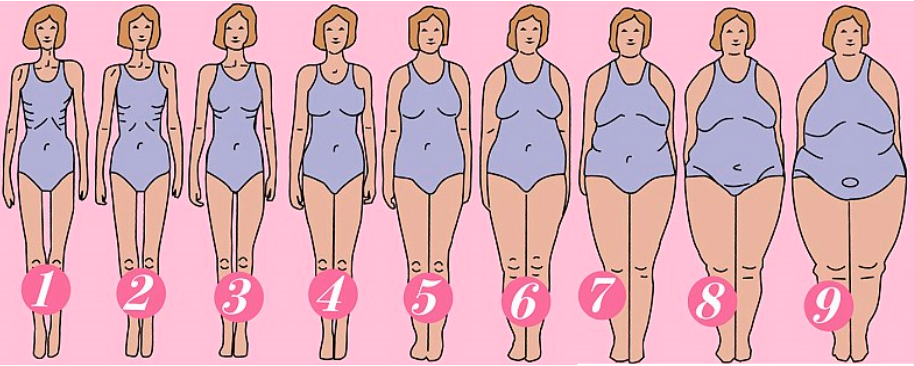
Figure A2. Current Body Size.